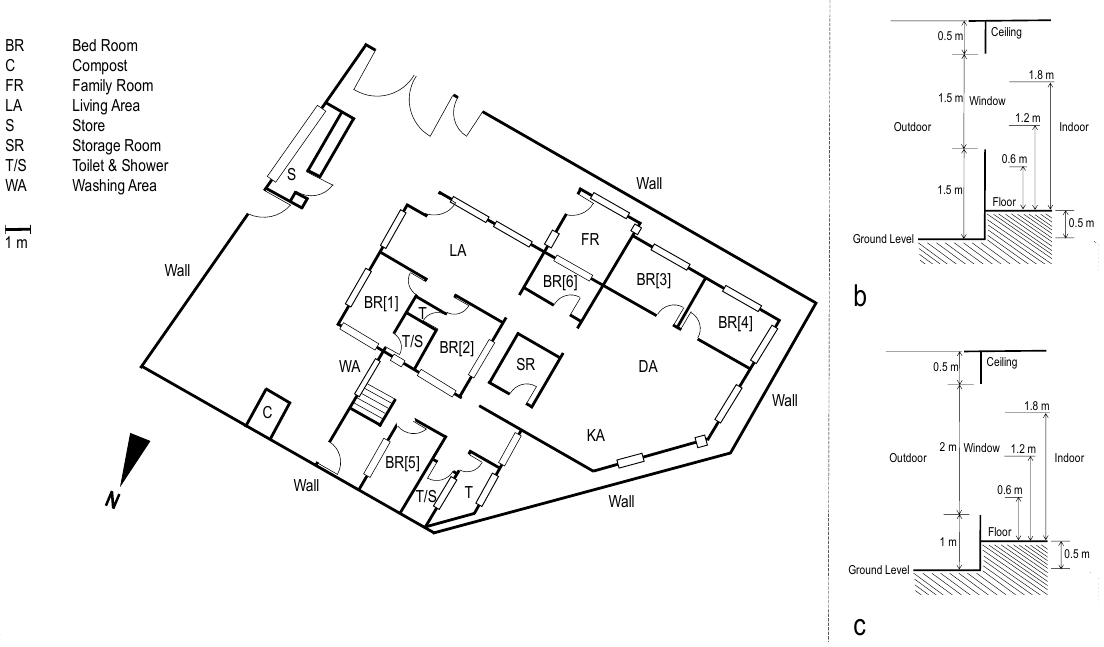
Figure 1. Walled, detached family house: ( a ) floor plan and lot perimeter; ( b ) vertical description inside the house not including living area; and ( c ) vertical description for the living area only.